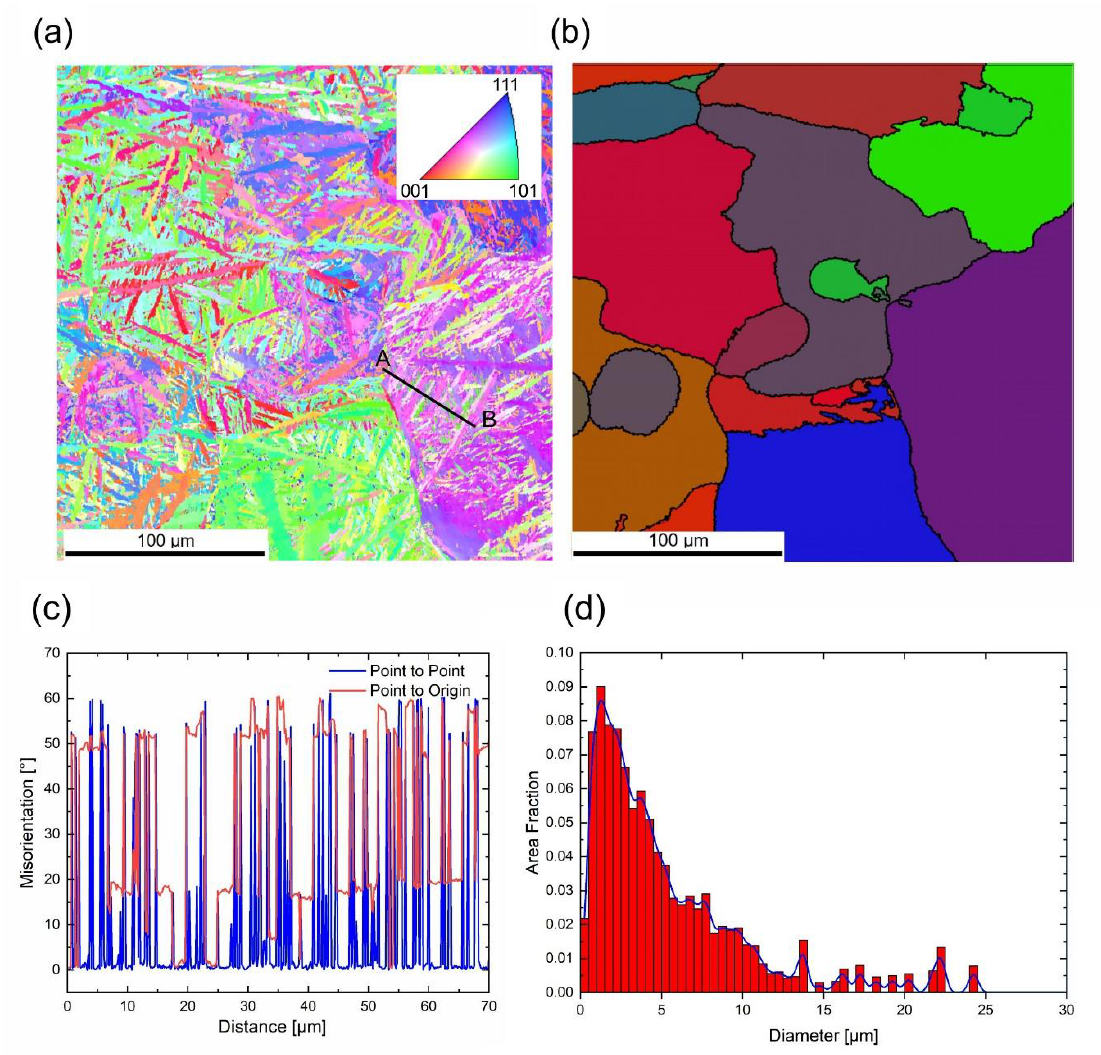
Figure 10. Microstructure analysis of the sample annealed and quenched in the HIP furnace. ( a ) An Inverse Pole Figure (IPF) map features the fine martensitic plates. ( b ) The corresponding parent austenite grains are reconstructed based on the EBSD result. ( c ) Point-to-point and point-to-origin misorientation profile of AB line in ( a ), which illustrates the width of martensite plates/blocks. ( d ) Martensitic plate width distribution.